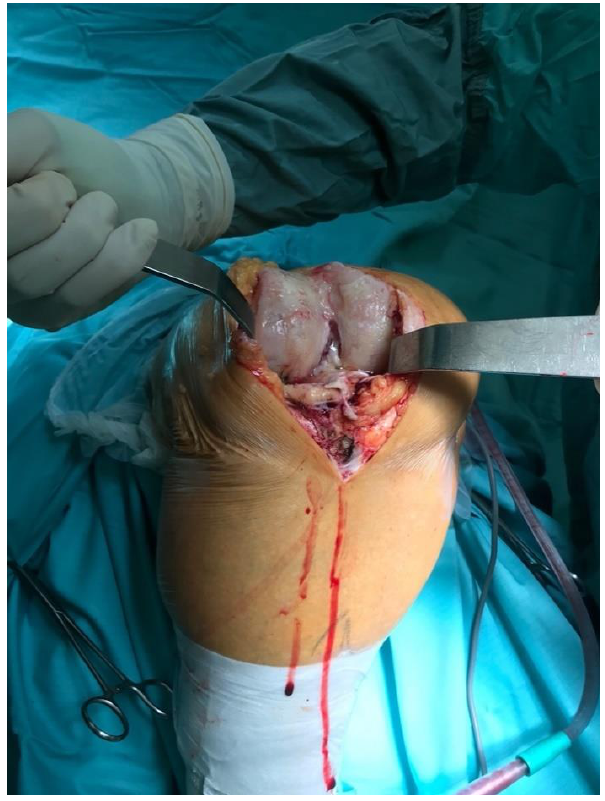
Figure 4. Medial displacement of the patella.